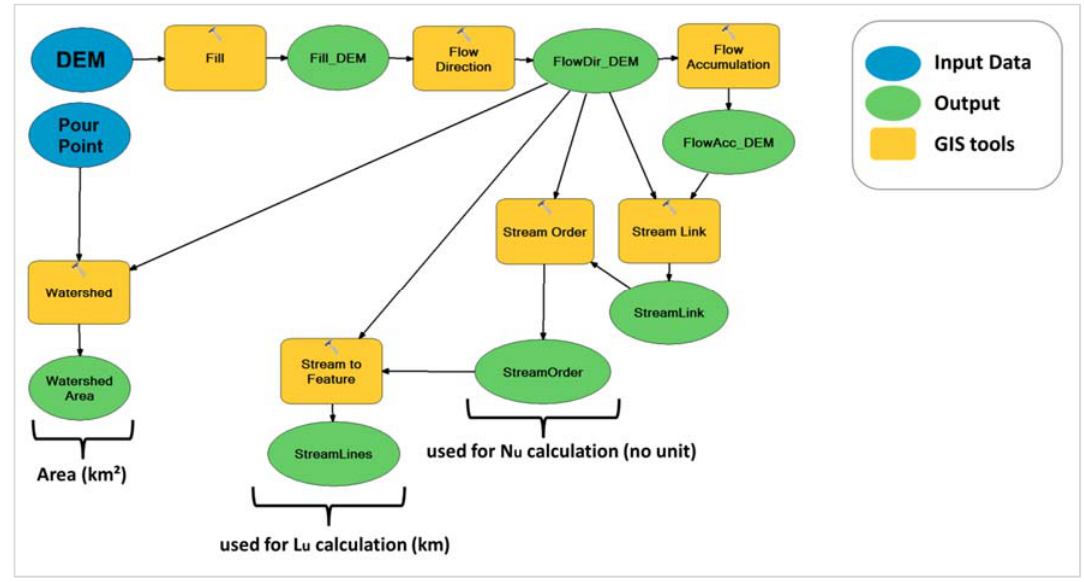
Figure 6. Conceptualized model of Infiltration Number (IN) and Total Catchment Area (TCA) calculation.